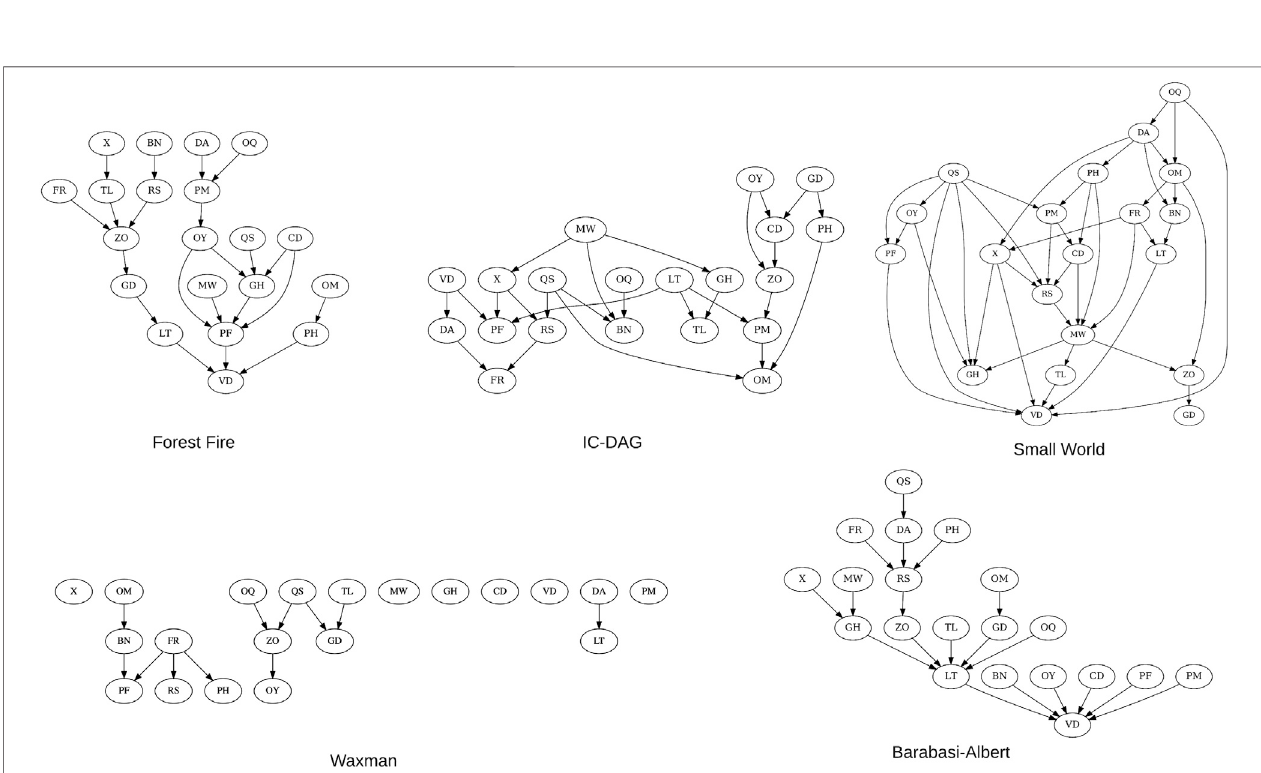
FIGURE 4 | 20-node examples of the fi ve structure types used to generate synthetic BNs. As the waxman structure type is a random geometric graph, the connectivity is proportional to the number of nodes – at 20 nodes the DAG remains sparse.